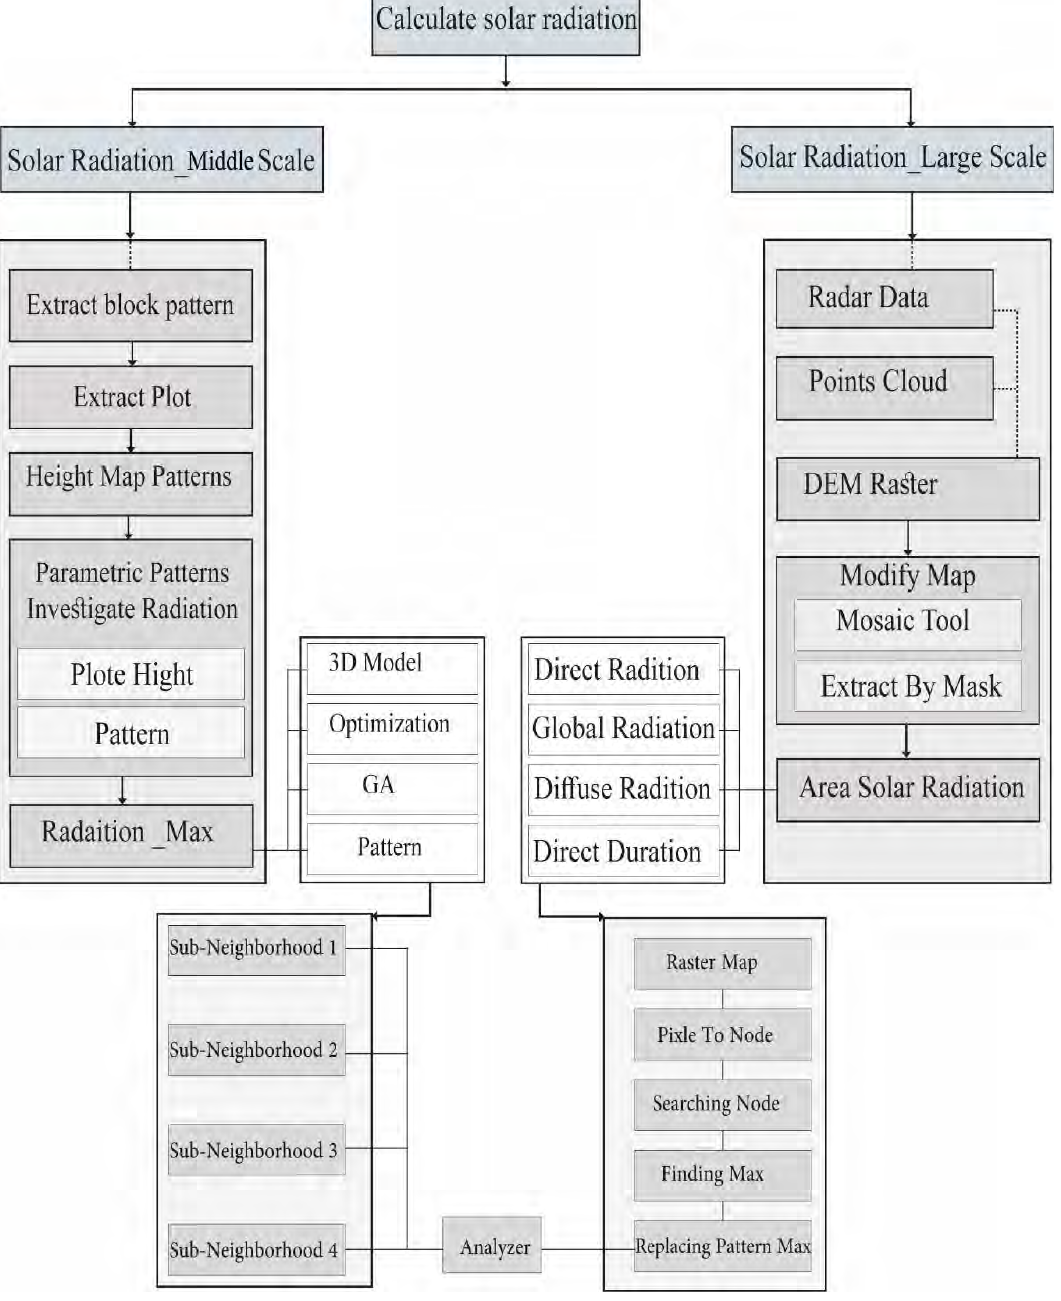
Figure 1 - General analysis of solar radiation at different levels of the